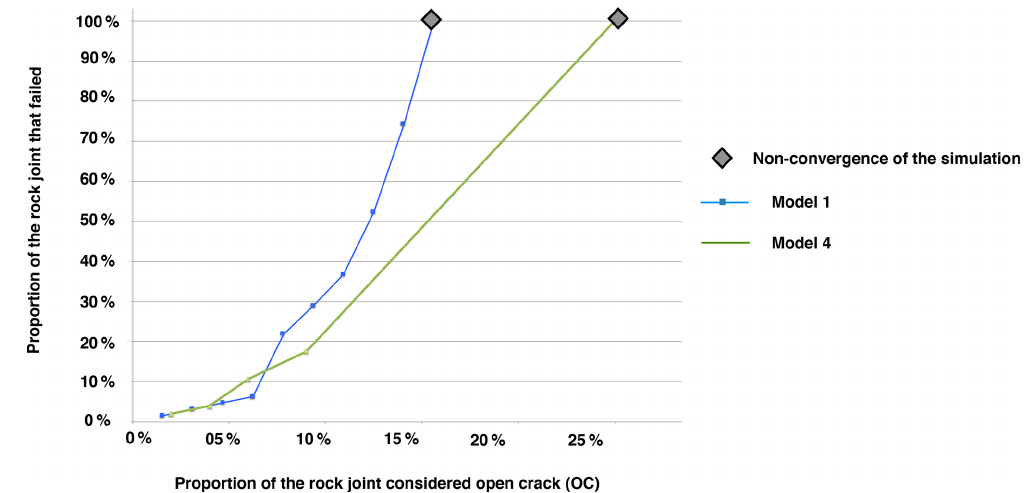
Figure 12. Propagation of rock bridge failure for (a) model 1 in the case where three types of contact are considered (open crack (OC), rock bridge (RB), rock bridge that failed (RBF)) and (b) model 4 if the contacts defined as rock bridges that failed are automatically changed to open crack (OC) – Scenario